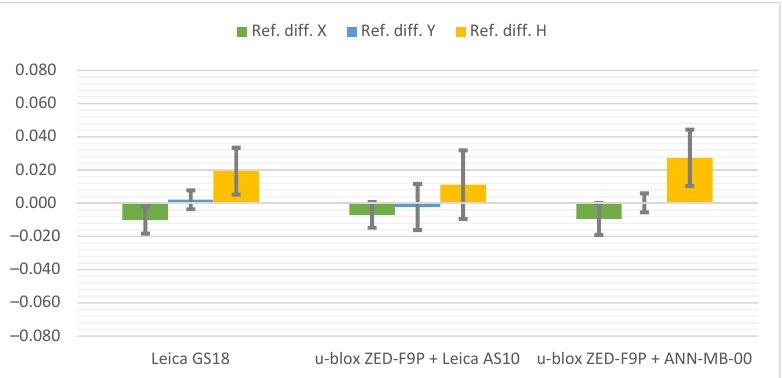
Figure 6. Cumulative graphs of measurement results at the Pt 1 station (open sky conditions; differences in relation to the reference points with standard deviations [m]).